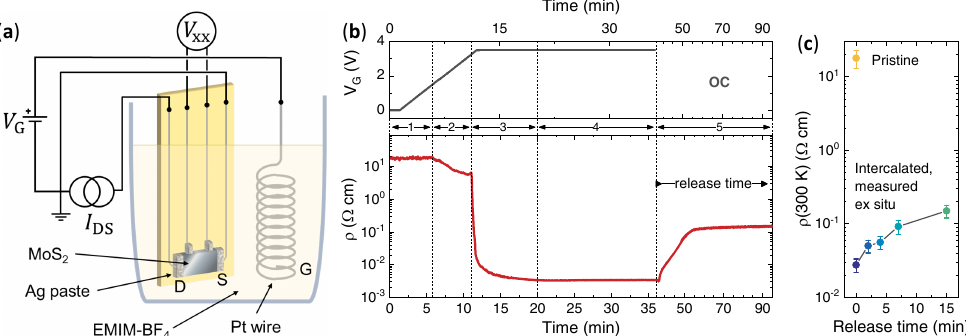
Figure 1. Electric field-driven ion intercalation. ( a ) Sketch of the ionic gating setup with the electrical connections. Source (S), drain (D) and gate (G) electrodes are explicitly highlighted. ( b ) Gate voltage (top panel) and resistivity (bottom panel) measured in situ as a function of time during a gating process. ( c ) Resistivity measured ex situ as a function of the release